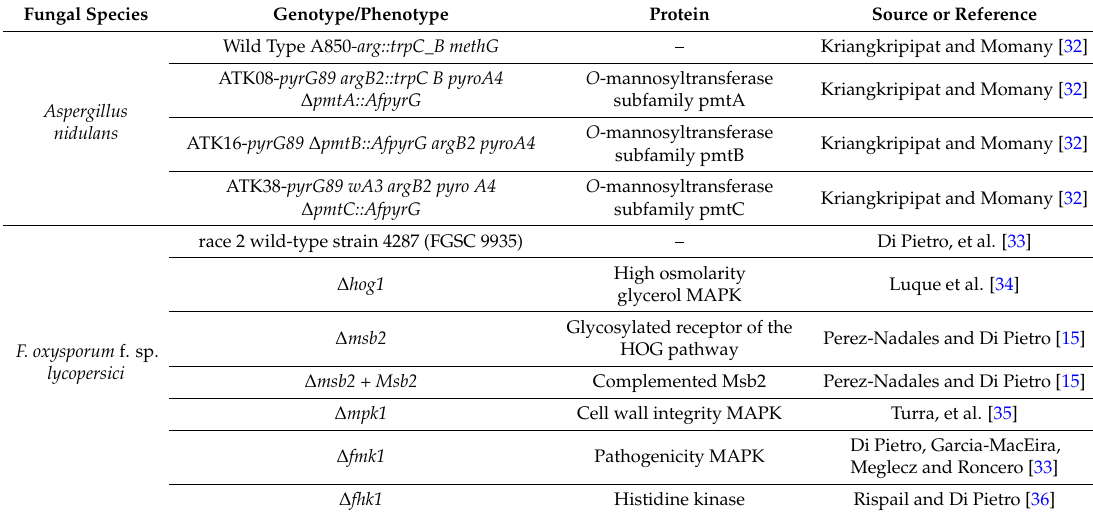
Table 1. List of fungal strains used in this